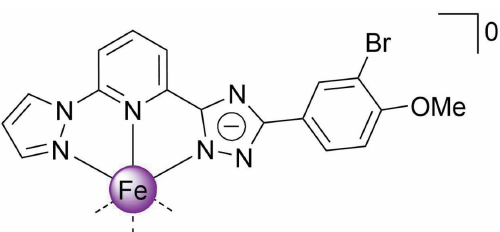
Table 1 Geometry (A˚ , (cid:4) ) of hydrogen bonds and C (cid:2)(cid:2)(cid:2) N interactions in the title